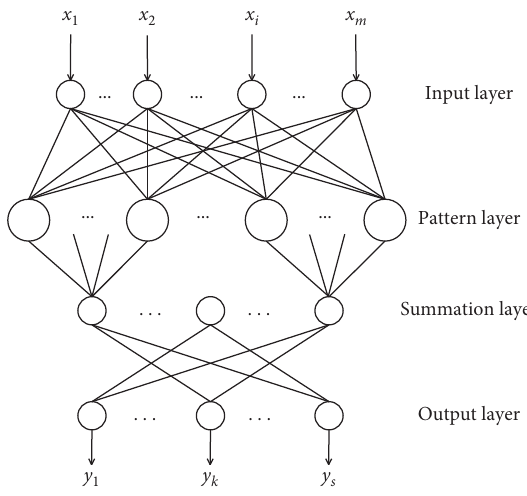
Figure 1: The structure of